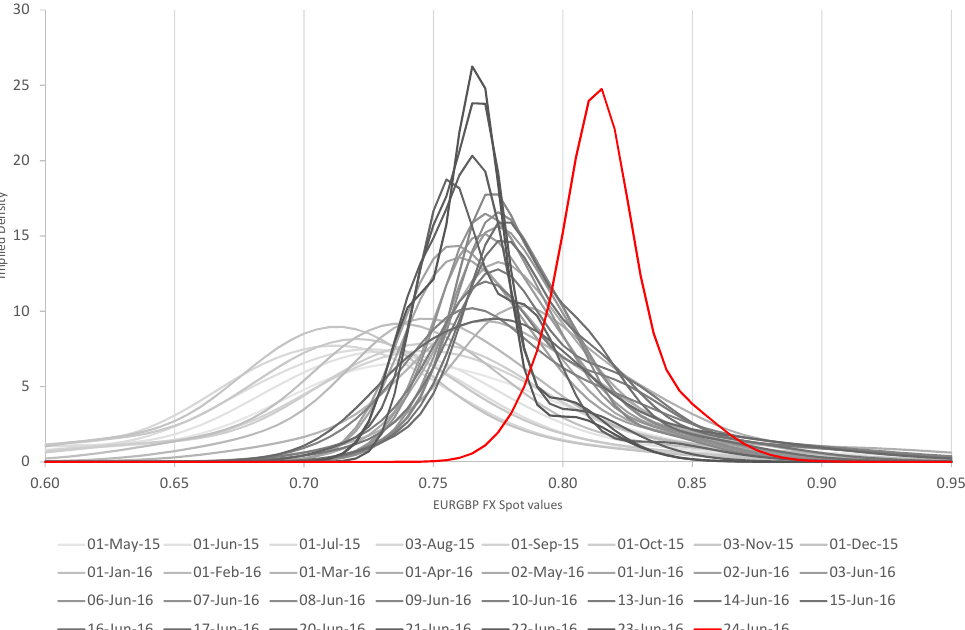
Figure 4. EURGBP implied densities for the Brexit referendum date from 1 May 2015 to 23 June 2016, sampled monthly from 1 May 2015 to 1 June 2016, then sampled daily (in grey/black), and for the next business day on 24 June 2016 (in red).